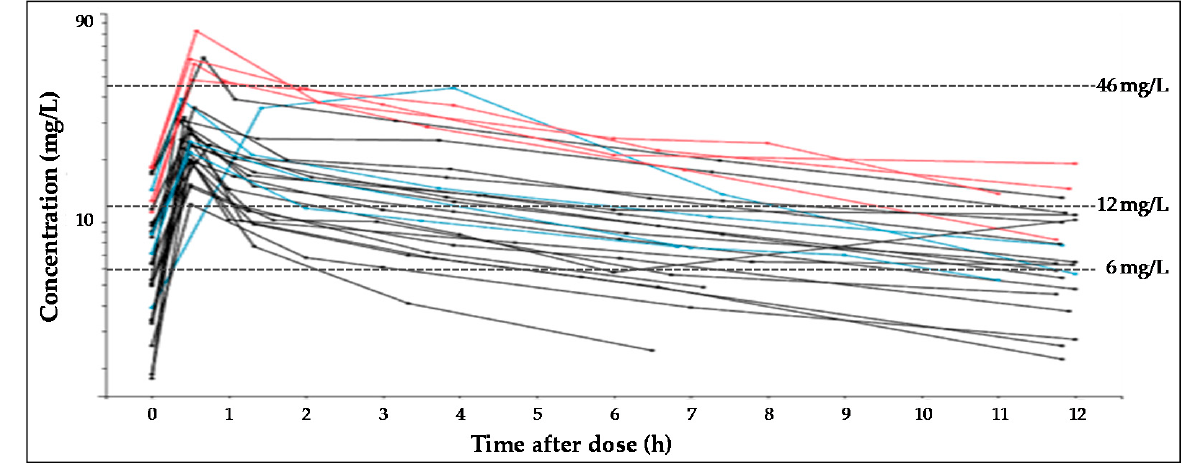
Figure 1. Spaghetti plots for plasma levetiracetam concentration-time profiles, according to dose received by each subject. In black, lines represent profiles after dose of 500 mg, blue lines, 1000 mg and red lines, 1500 mg. Dashed lines represent the target concentration values (6 mg/L, 12 mg/L or 46 mg/L).